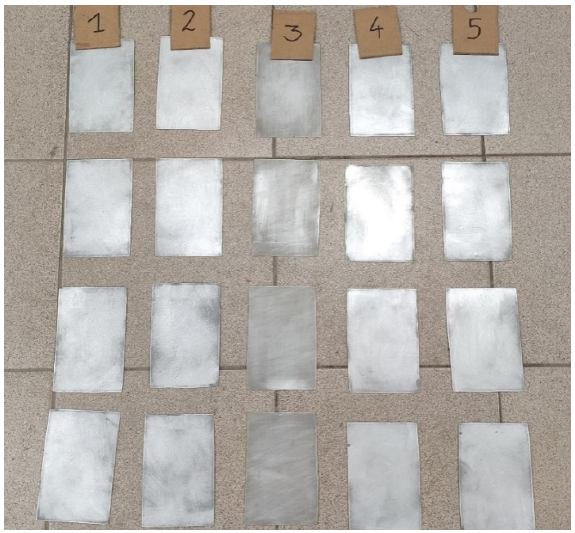
Figure 1. Steel samples after removing varnish coating.